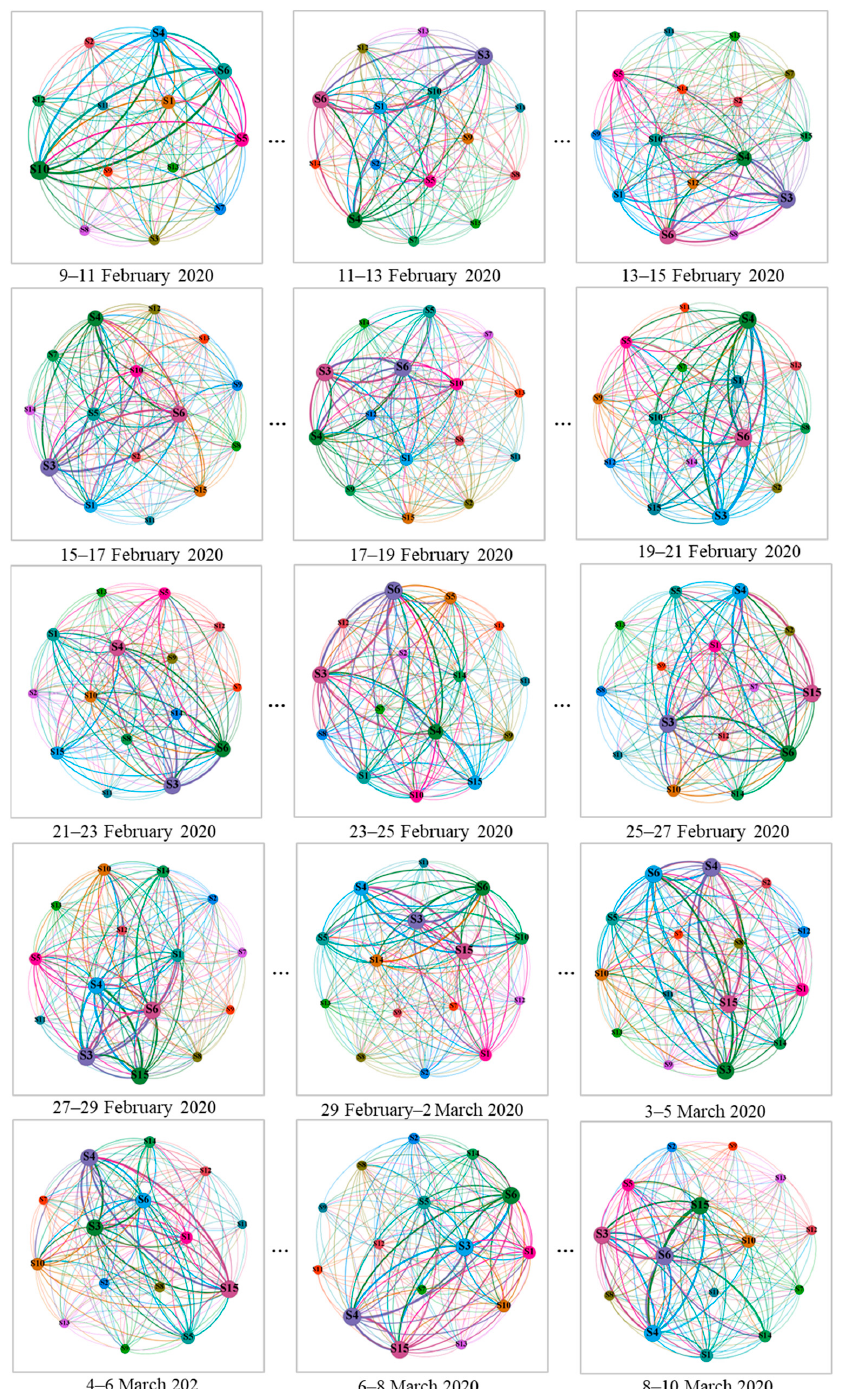
Figure 8. Semantic change network (8 February–10 March 2020) (S1: Fears and worries; S2: Ques- tioning the government and media; S3: Criticizing bad habits; S4: Factual comments; S5: Taking